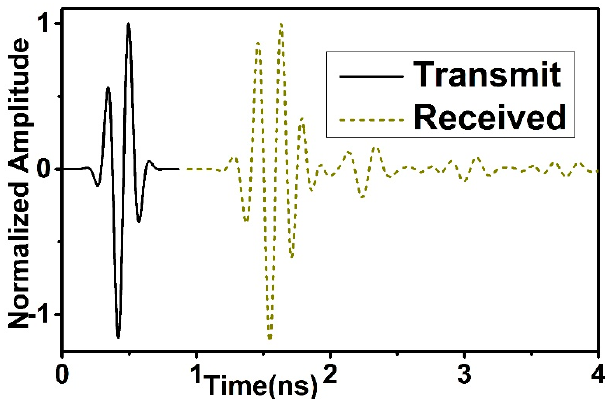
Figure 7. Transmitted and received a pulse of prototype.